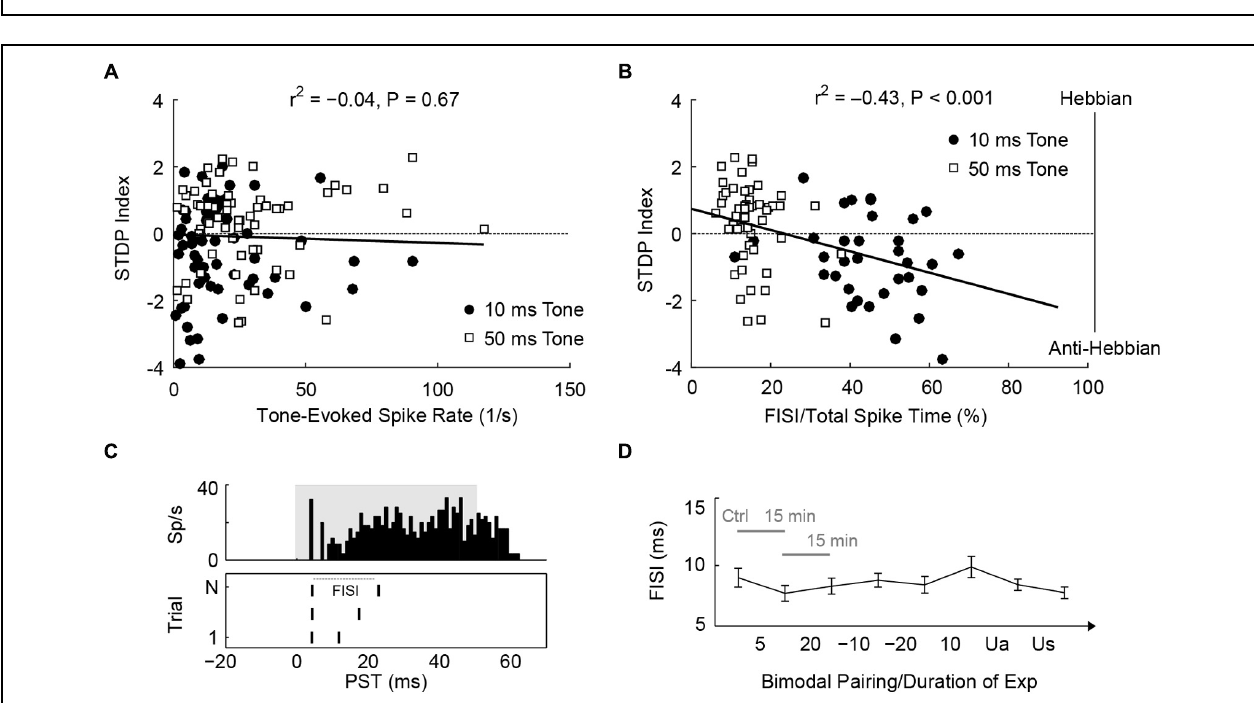
FIGURE 6 | STDP is determined by first inter-spike intervals of tone-evoked responses. (A) STDP index does not correlate with tone-evoked spike rate. Tonal responses (10 and 50 ms) were evaluated before STDP assessment. (B) An example for calculating FISI in a pauser unit (upper panel; 50 ms tones at BF and 20 dB SL). The raster plot (lower panel) shows first and second spikes across trials ( N ). (C) Mean FISI as a percentage of total evoked